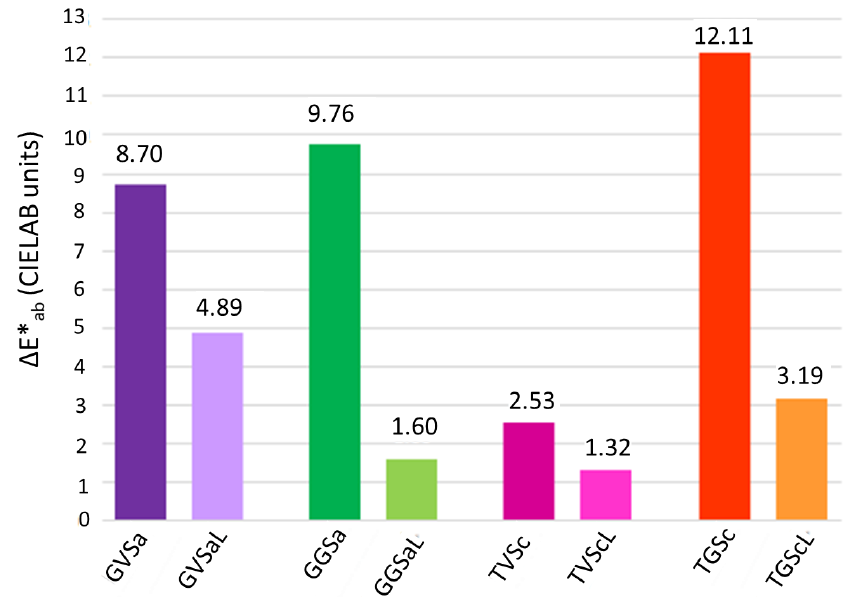
Figure 5. ∆ E * ab (CIELAB units) for gneiss and travertine surfaces after being treated either with a solvent mixture or the combined methodology based on the use of the solvent mixture followed by laser working at 532 nm. ∆ E * ab was computed considering the color of the surface before to be painted as the reference. Check Table 3 for sample labels.